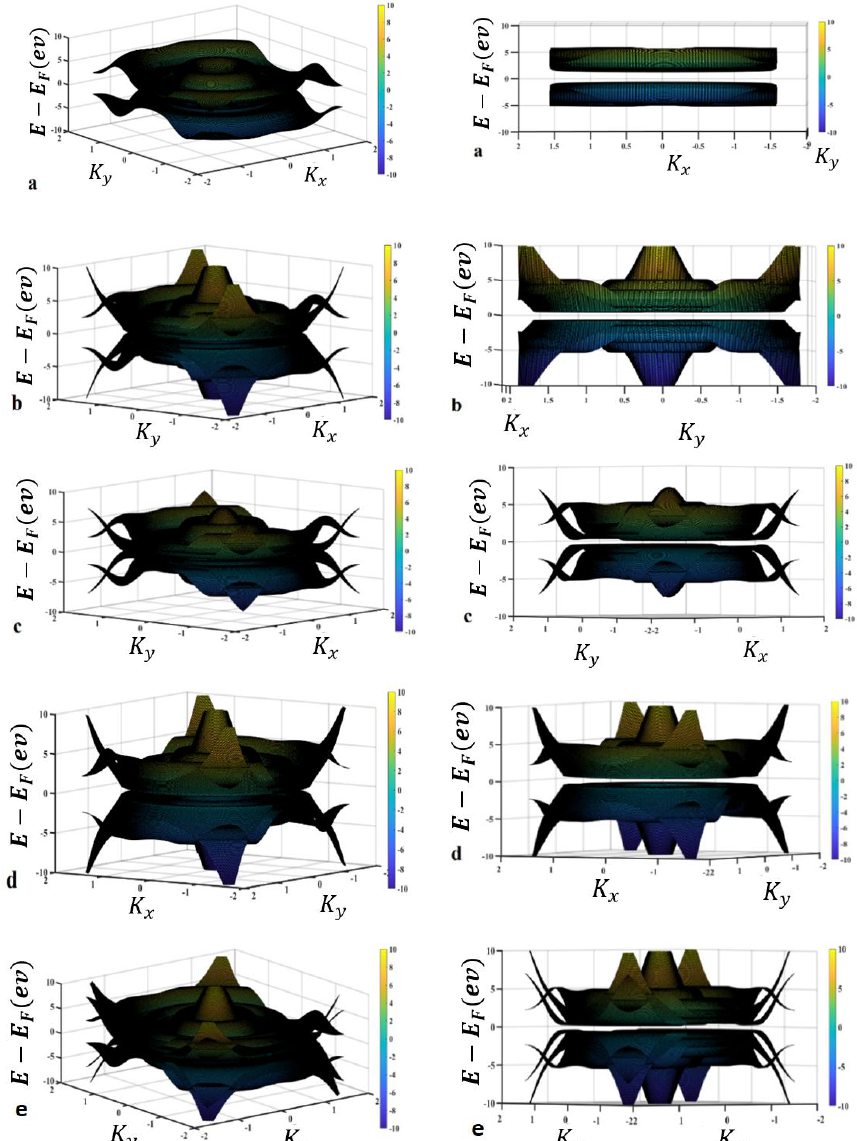
Figure 3. ( a ) Dispersion relation plotted for E 1 , which indicates a band gap = 2.312 ev; ( b ) dispersion relation plotted for both E 1 , and E 2 , in which the minimum band gap is found to be 1.1988 ev; ( c ) dispersion relations for both E 1 and E 3 are compared, and a minimum of about 0.7182 ev is reported; ( d ) dispersion relations for both E 1 and E 4 are compared, and a minimum band gap of about 1.304 ev is shown; ( e ) dispersion relation results for E 1 , E 2 , E 3 , and E 4 are compared, and a minimum band gap of about 0.7182 ev is addressed. Note: In the right-hand side of each figure, a two-dimensional view is presented with the same